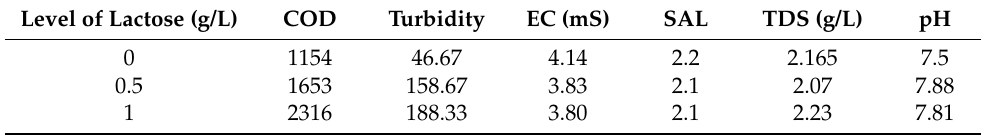
Table 3. Characteristics of SW-BSA and